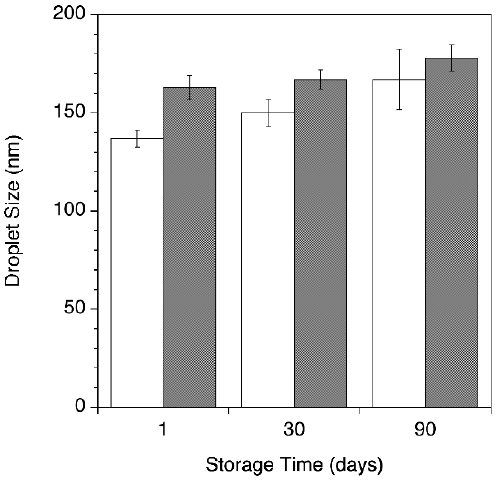
Figure 3. Nanoemulsion droplet size evaluated during storage for ClFPh-CHA-loaded (gray bars) and blank nanoemulsions (white bars).